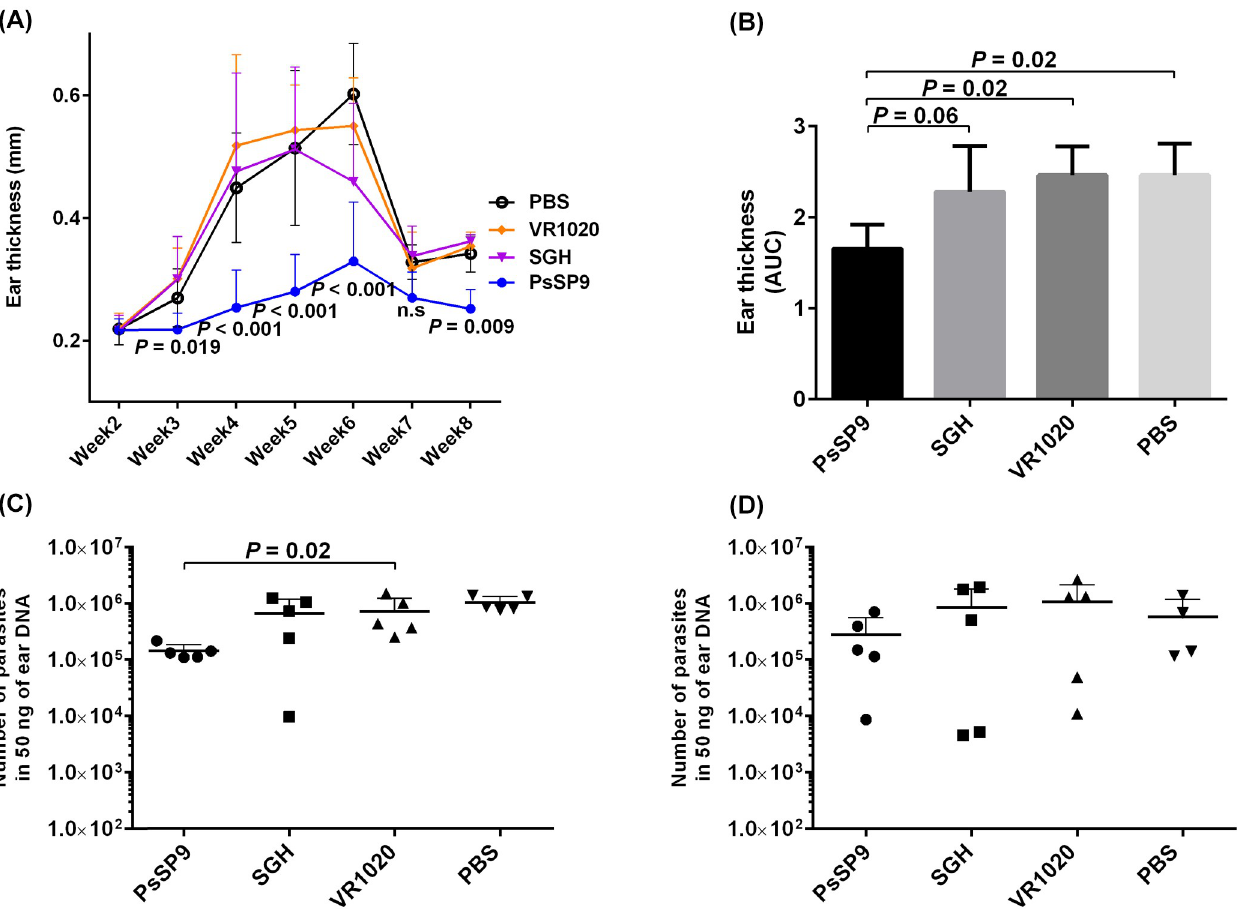
Fig 5. The course of infection in PsSP9 -immunized BALB/c mice after challenge with L . tropica plus Ph . sergenti SGH. BALB/c mice (ten mice per group) were immunized in the right ear three times at two-week intervals with Ph . sergenti SGH, plasmid encoding PsSP9, empty plasmid (VR1020) or PBS. Two weeks after the last immunization, mice were challenged with metacyclic L . tropica plus Ph . sergenti SGH in the contralateral ear. Data shown are from one representative of two independent experiments. (A) The course of nodule development was monitored weekly by measuring ear thickness. Bars represent the means ± SD). (B) Disease burden was calculated as the area under the curve (AUC) obtained from (A). Ear parasite loads were determined at (C) one and (D) two months post-infection by Real-Time PCR (four to five mice per group). The p value in A, C and D are indicated for each vaccinated group compared with control plasmid group (VR1020) and the p value in B is indicated for each groups compared with PsSP9 plasmid